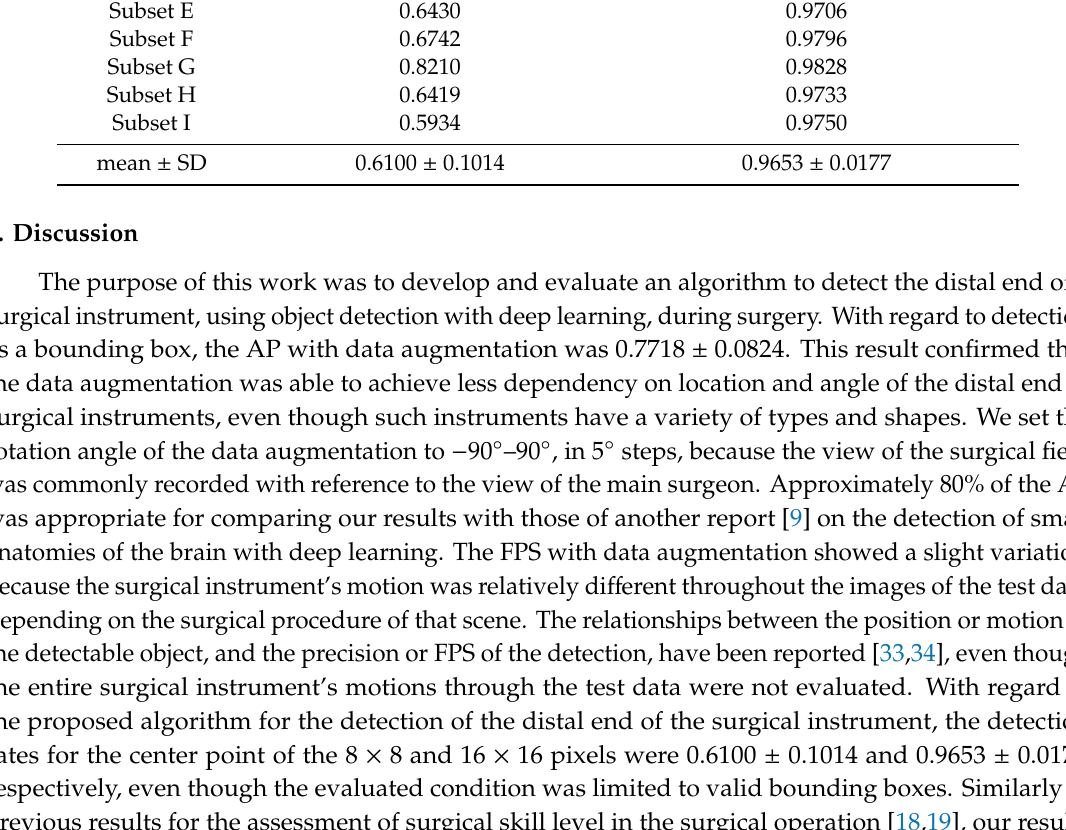
Table 2. The detection rate of the distal end of the surgical instrument.